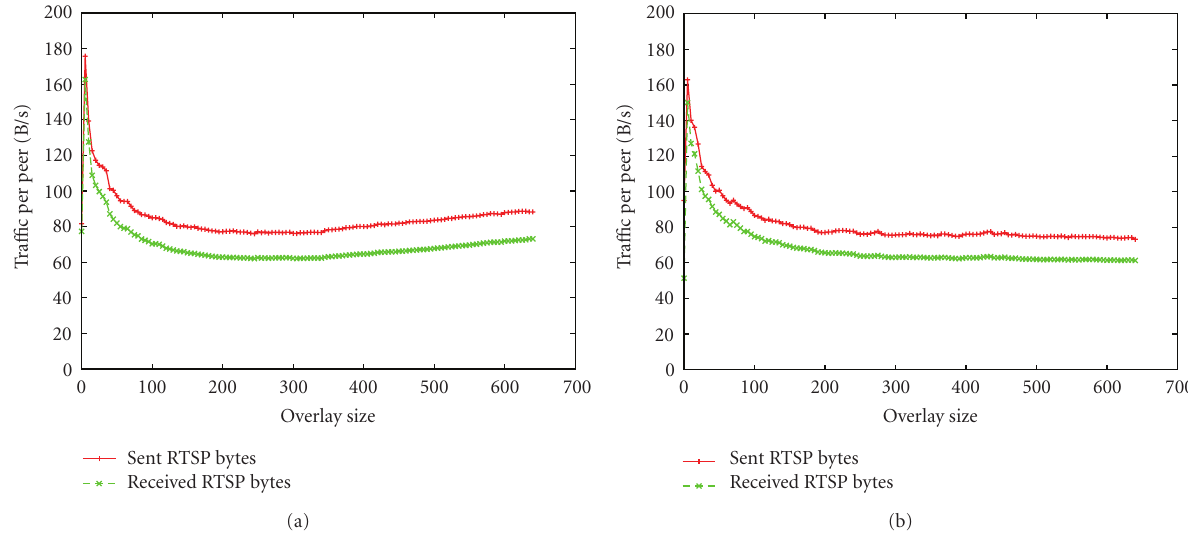
Figure 14: The amount of sent and received RTSP data, (a) maximum cluster size 30 peers, and (b) maximum cluster size 70 peers.